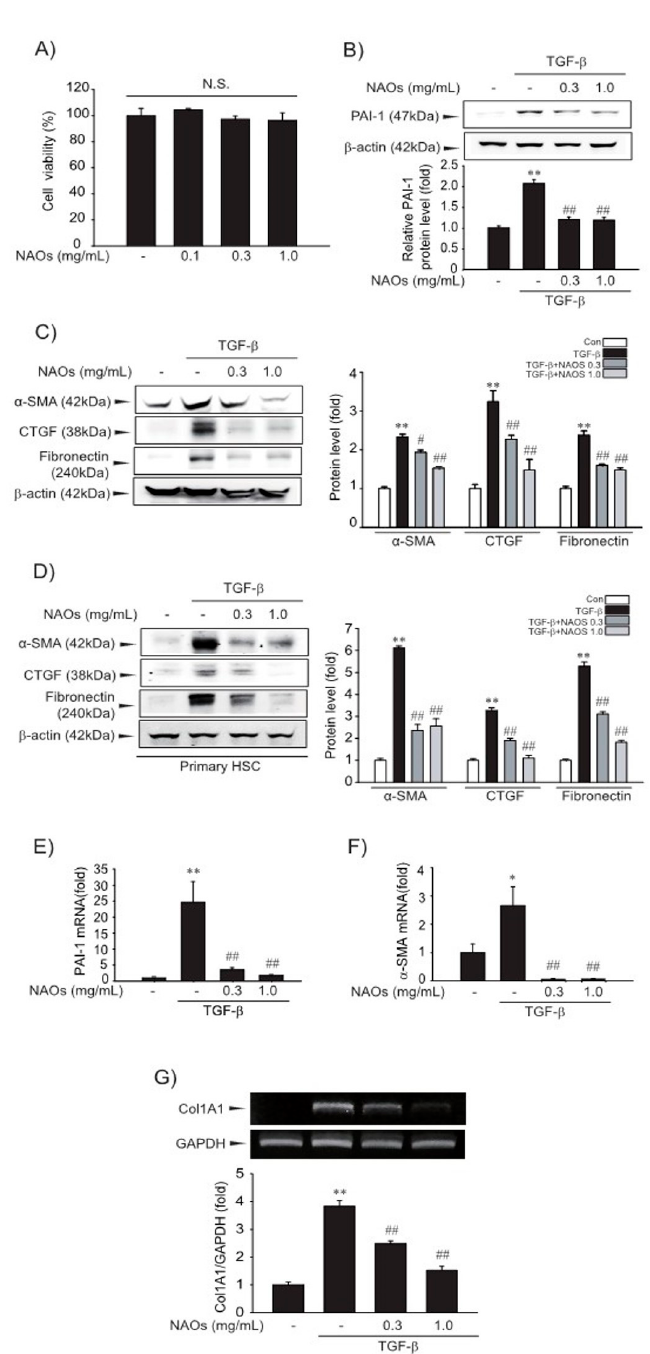
Figure 1. Inhibition of TGF- β -mediated fibrosis markers by neoagarooligosaccharides (NAOs). ( A ) MTT assays for cell viability. Effect of NAOs (0.1–1.0 mg/mL, 12 h treatment) on cell viability of LX-2 cells, a well characterized human HSC line evaluated using MTT assays ( n = 3). N.S., not significant. ( B – D ) Effect of varying concentrations of NAOs on TGF- β -mediated fibrogenic protein expression. Cells were treated with 0.3–1.0 mg/mL NAOs and incubated with TGF- β (1 ng/mL) for 6 h. Protein levels in the cell lysates were determined by immunoblotting ( n = 3). ( E , F ) Real-time PCRanalysis. Cells were treated with 0.3–1.0 mg/mL NAOs for 30 min, and then further incubated with TGF- β for 3 h. The α -SMA and PAI-1 transcripts were analyzed by Real-time PCR, with the mRNA level of GAPDH used as a housekeeping gene ( n = 3). ( G ) Collagen (Col) 1A1 transcripts analyzed by RT-PCR assays. Results were confirmed by repeated experiments ( n = 3). Data represent the mean ± standard error (S.E.) of three replicates; ** p < 0.01, * p < 0.05, vs. vehicle-treated control; ## p < 0.01, # p < 0.05, vs. TGF- β alone. Minus sign (-) indicates untreated with